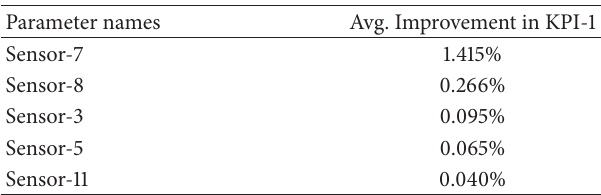
Table 7: Ranking of sensors based on average production savings